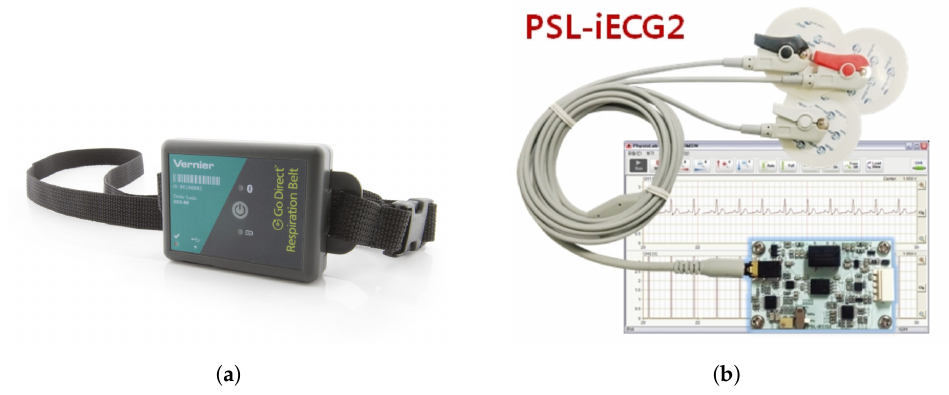
Figure 5. ( a ) Reference respiration belt sensor, ( b ) Reference ECG sensor